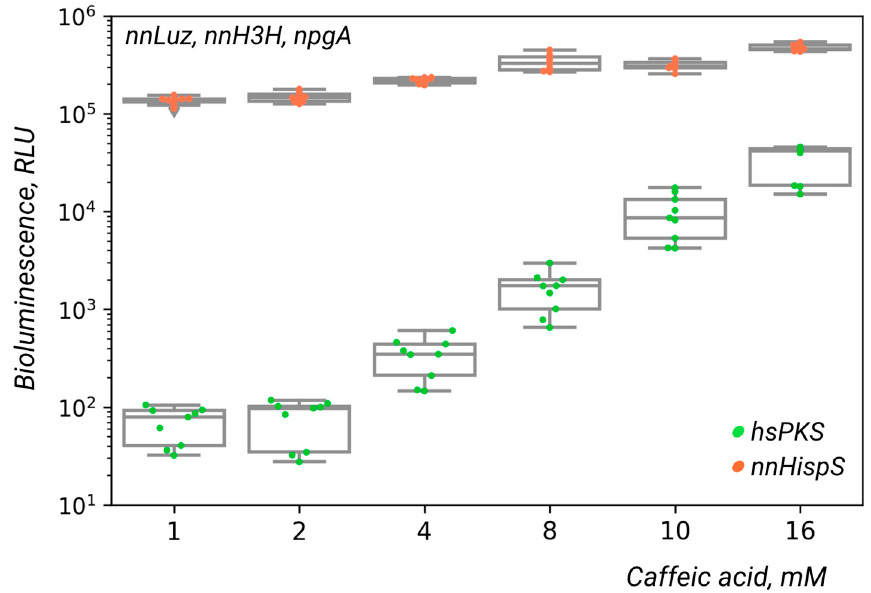
Figure 3. Luminescence emitted by Pichia pastoris GS115 yeast colonies expressing nnLuz, nnH3H, npgA, and full-length polyketide synthase from H. sublateritium or nnHispS after treatment with different concentrations of caffeic acid.